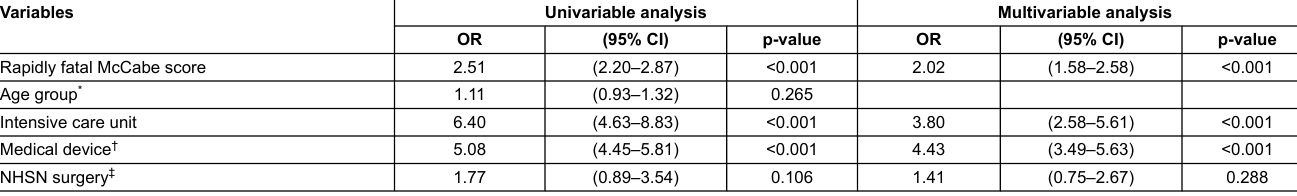
Table 2: Uni- and multivariable risk factor analysis – multicentre point prevalence survey, Switzerland